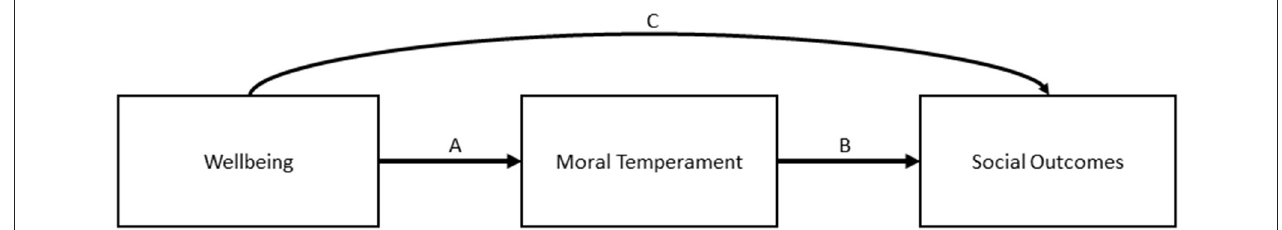
FIGURE 1 | Overall model predicting sociomoral temperament and social outcomes from